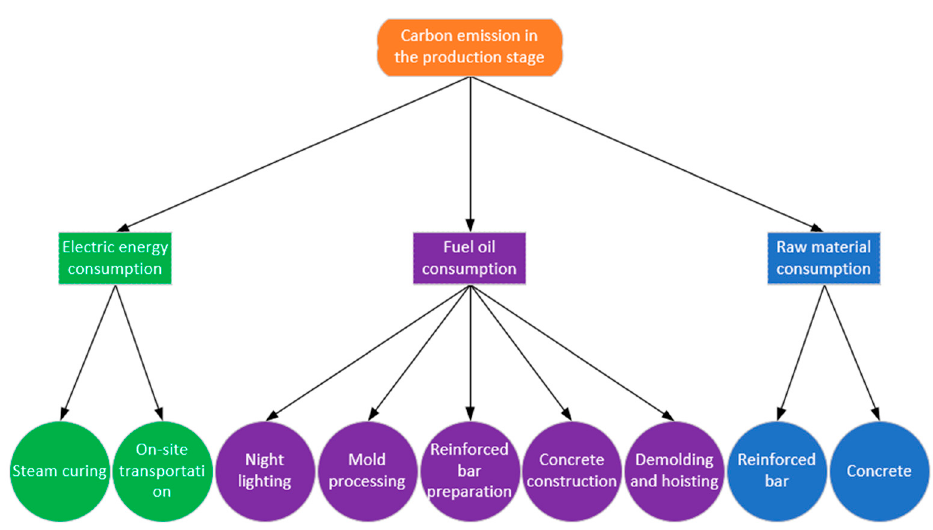
Figure 2. Carbon emissions sources of prefabricated components during the production stage.